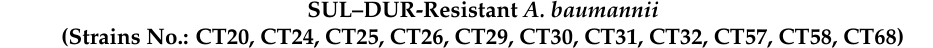
Table 4. Virulence factors encoded by the eleven A. baumannii isolates resistant to